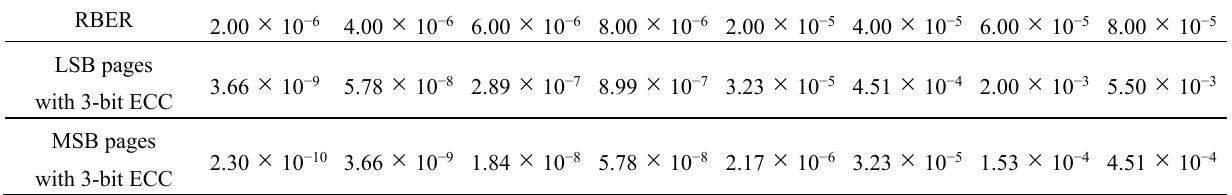
Table 1. Quantized uncorrectable page error rate and corresponding RBER (Raw Bit Error Rate).